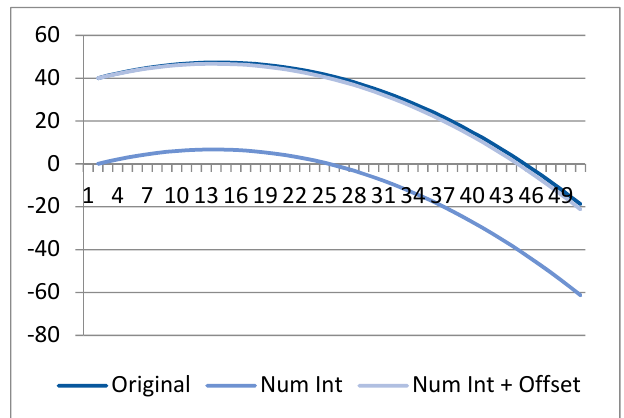
Figure 12. Effect of numerical methods on signal reconstruction. Figure 12. E ff ect of numerical methods on signal